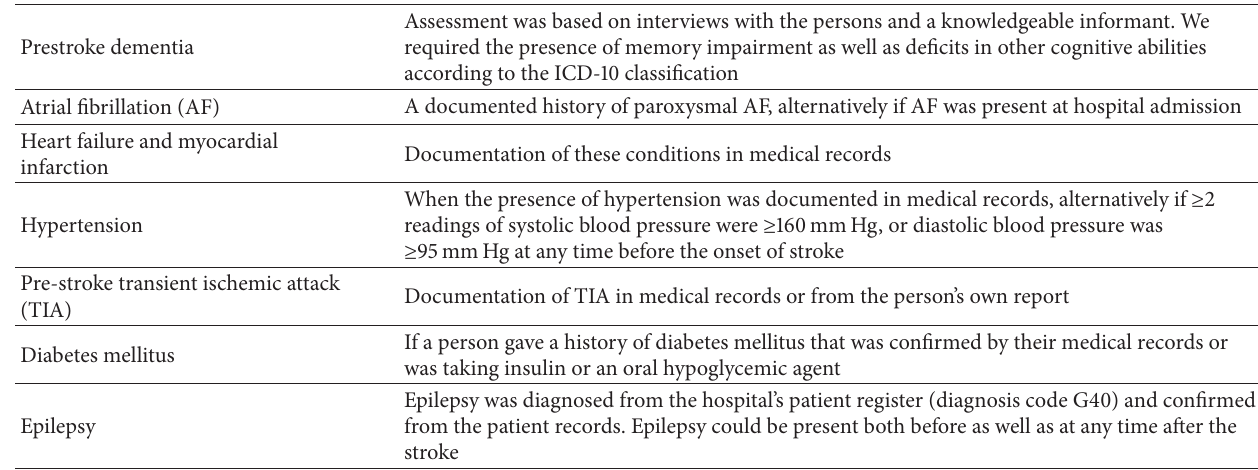
Table 1: Diagnosis of associated medical